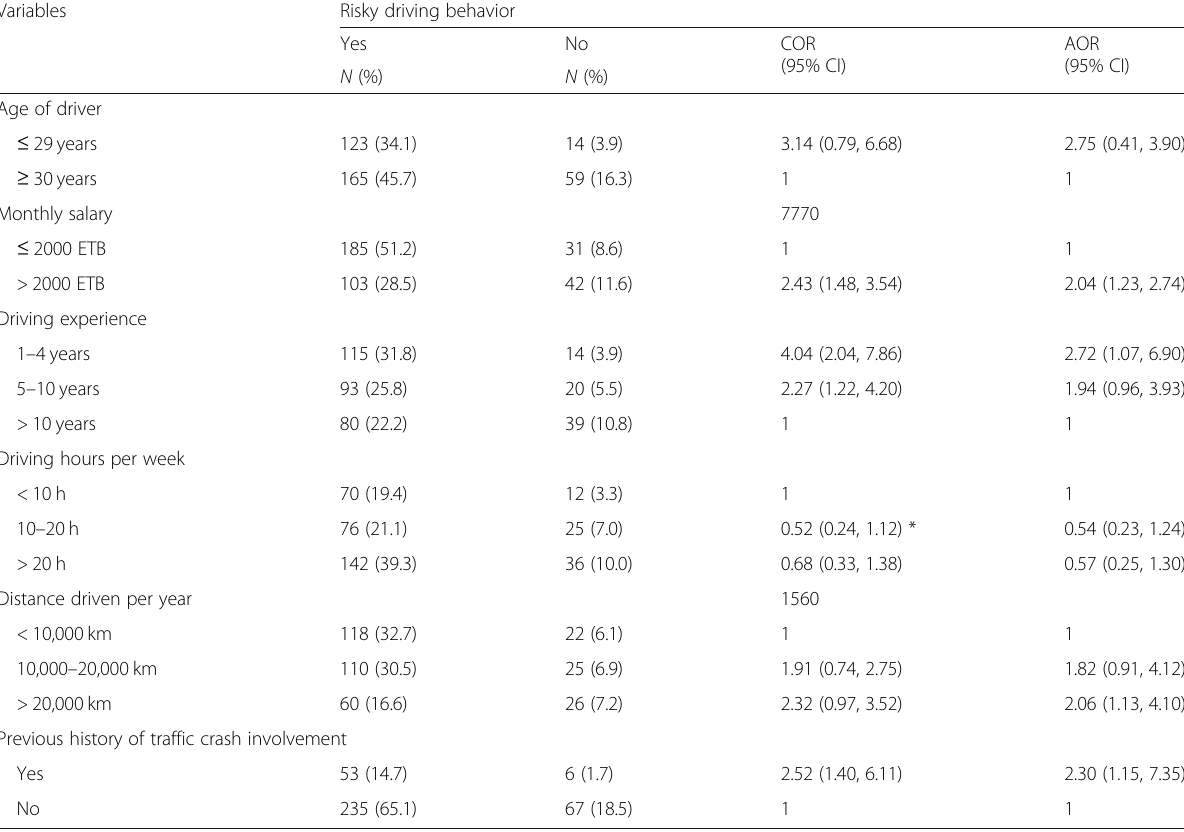
Table 3 Factors associated with RDB among drivers in Bahirdar city, Ethiopia, 2016 (N = 361) Variables Risky driving